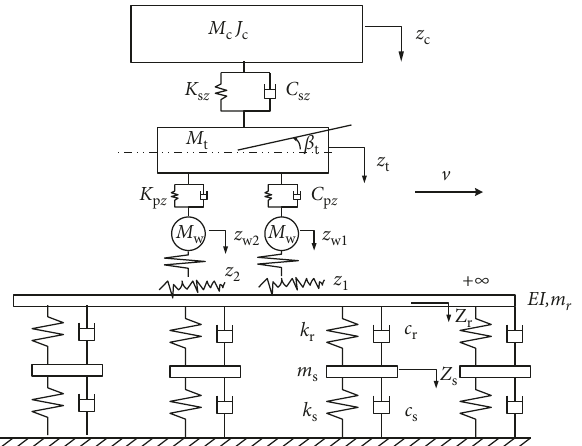
Figure 1: The half-vehicle-track coupled nonlinear